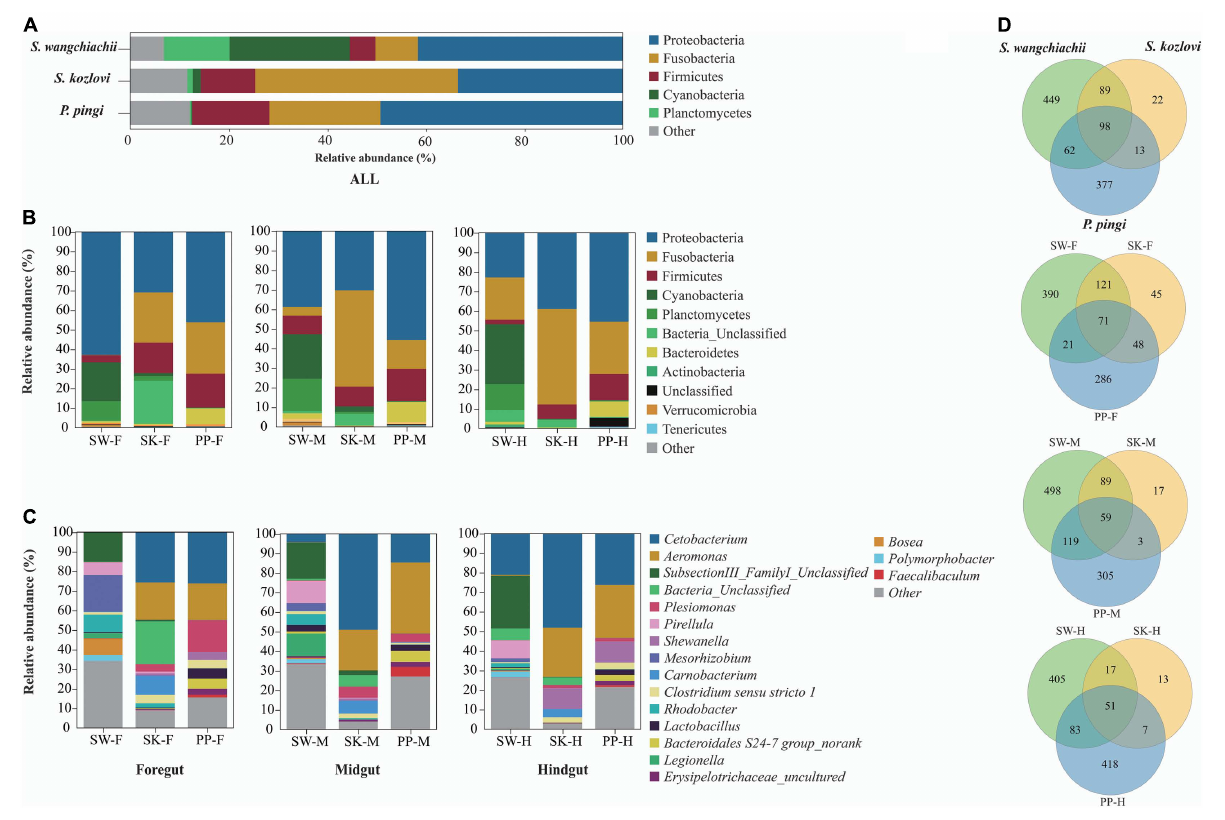
Frontiers in Microbiology |